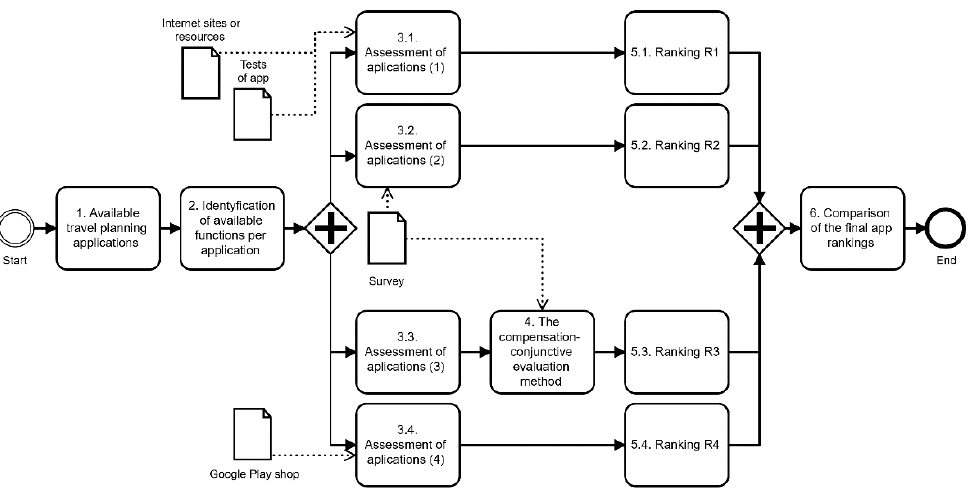
Figure 10. Concept of methodology.